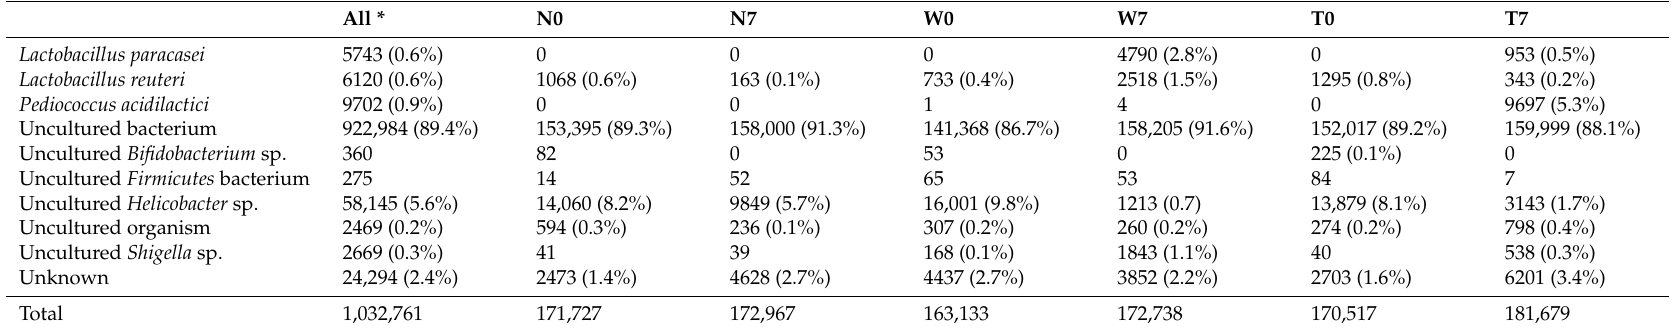
Table 3. Number of sequenced reads for known bacteria species in six